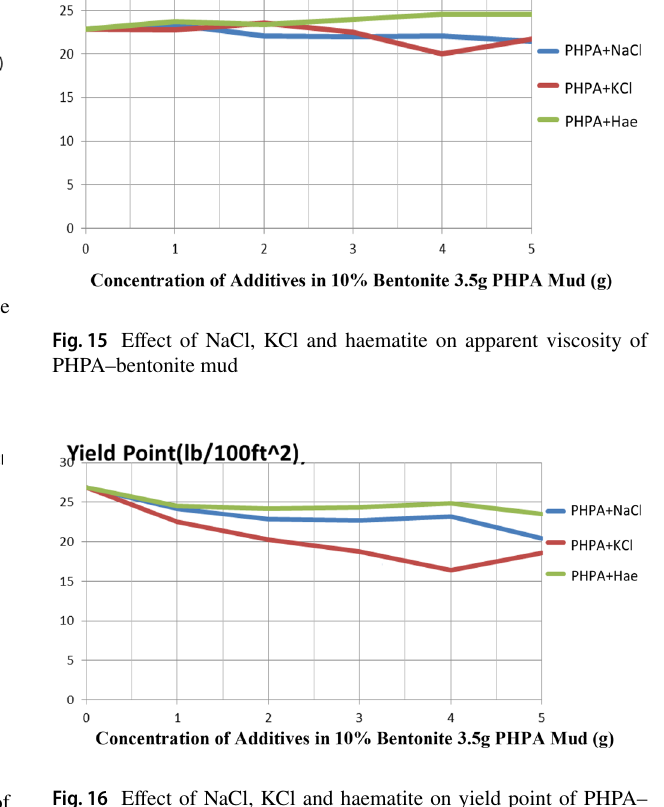
Fig. 14 Effect of NaCl, KCl and haematite on plastic viscosity of PHPA–bentonite mud